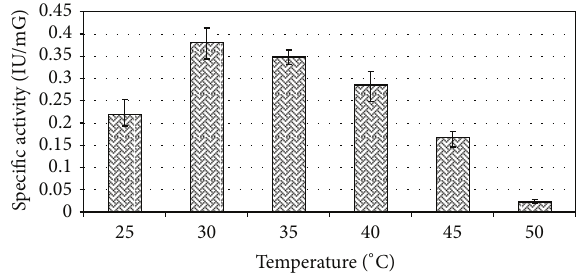
Figure 4: Effect of temperature on ADI enzyme production in E. faecium sp. GR7. Results are expressed as the mean ± S.D ( 𝑛 = 3 ), 𝑃 value < 0.05.